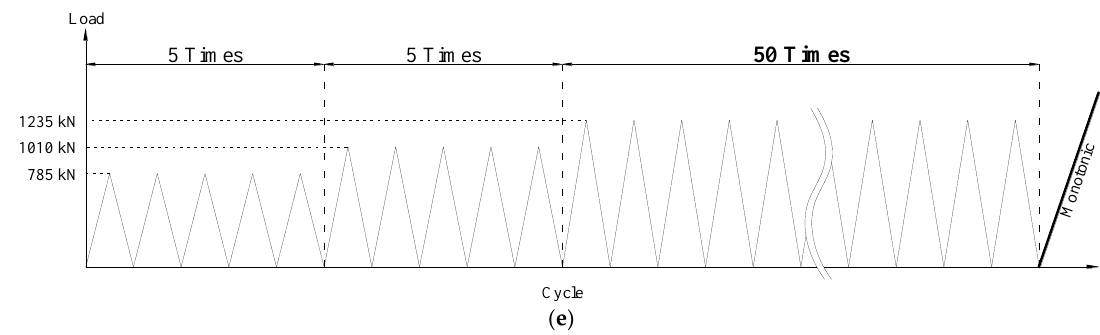
Figure 9. Repeated load types for Y-type perfobond rib shear connectors. ( a ) Load type 1, ( b ) Load type 2, ( c ) Load type 3, ( d ) Load type 4 and ( e ) Load type 5. Table 8. Repeated loading test programs. Table 7. Intensities of repeated loads for each stage.